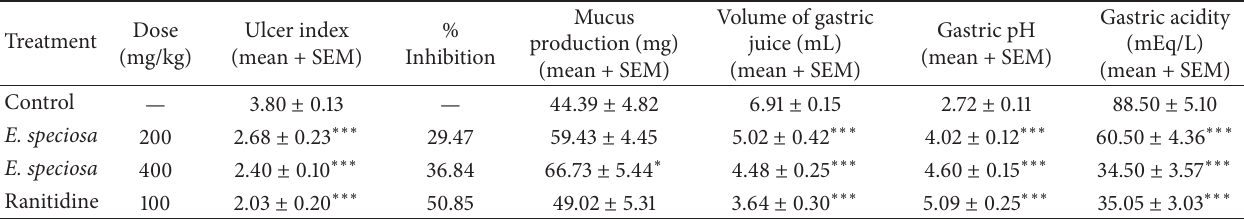
Table 9: Effects of duodenally administered aqueous extract of E. speciosa on gastric ulceration and secretion in pylorus-ligated rats treated with